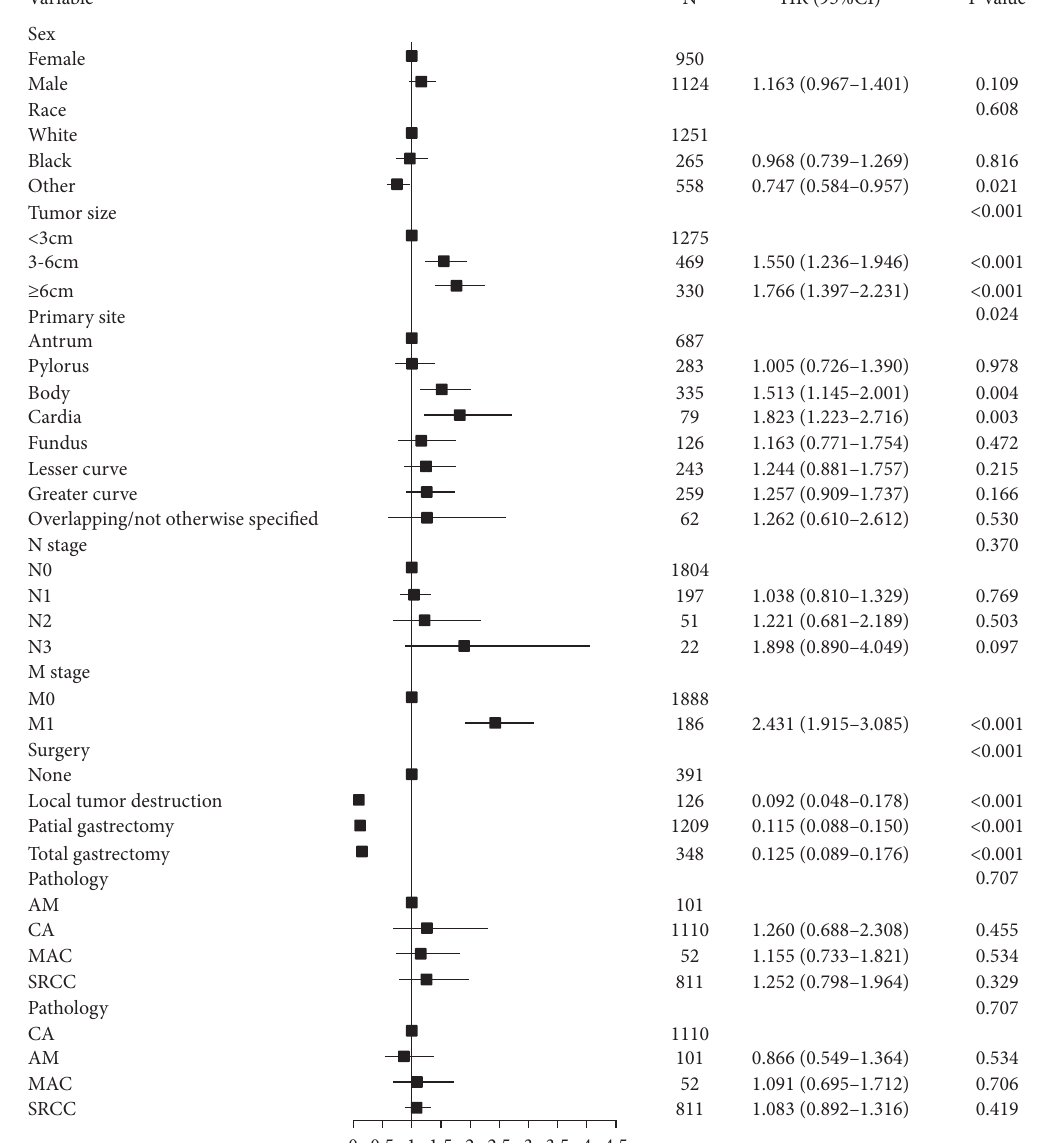
MAC (Figure 3, HR: 0.782, 95% CI: 0.664–0.922, P � 0 . 003; HR: 0.787, 95% CI: 0.634–0.976, P � 0 . 029) but similar